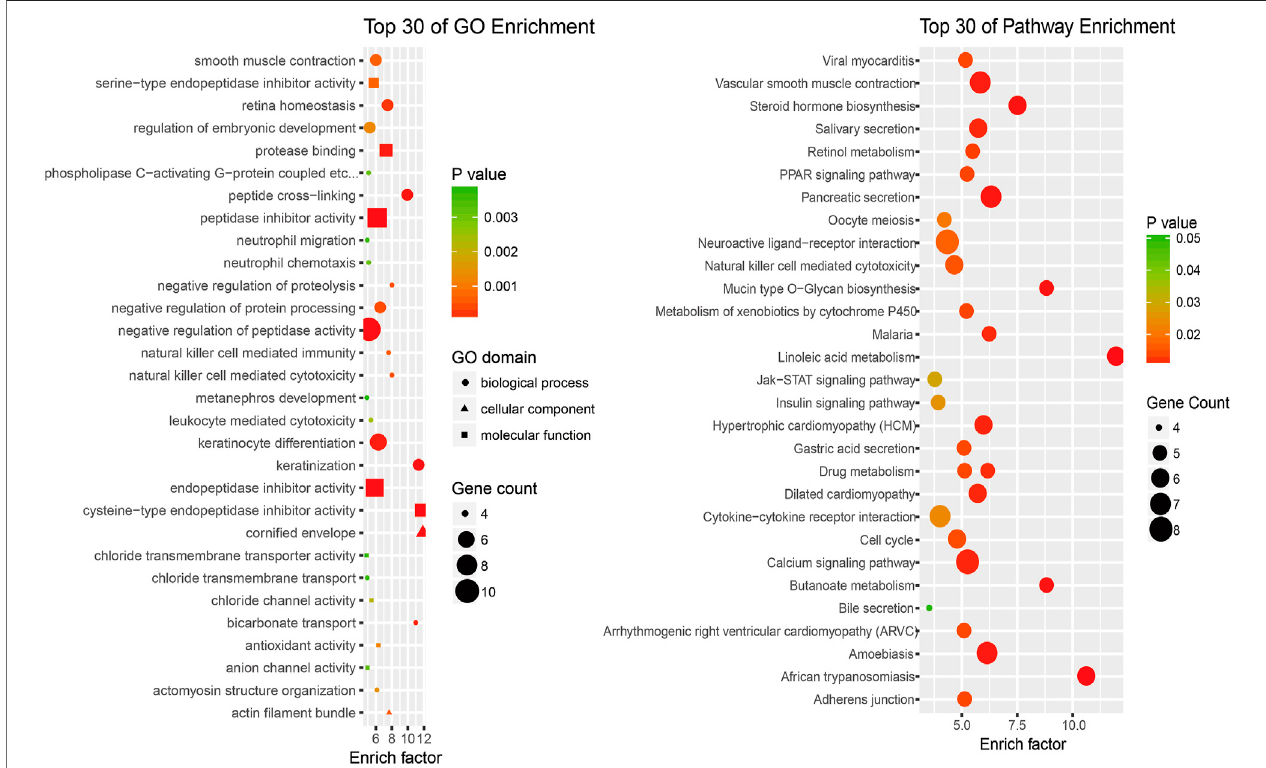
FIGURE 4 | An enrichment analysis of mRNAs coexpressed with lncRNAs (A) Top 30 GO enrichment terms (B) Top 30 KEGG pathway enrichment terms.